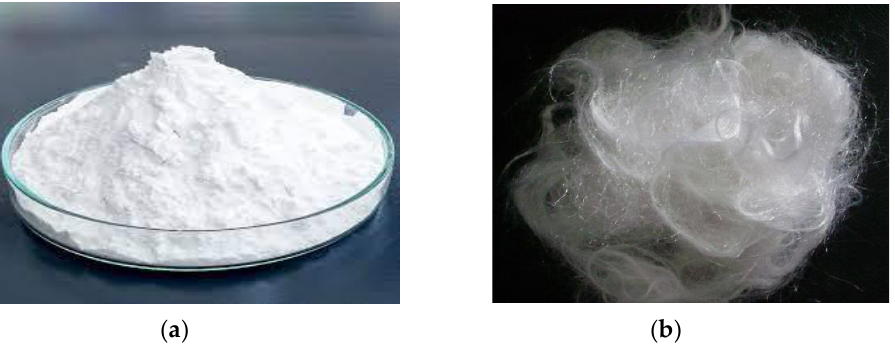
Figure 6. Types of fillers. ( a ) Fine powdered filler; ( b ) fiber-type filler.